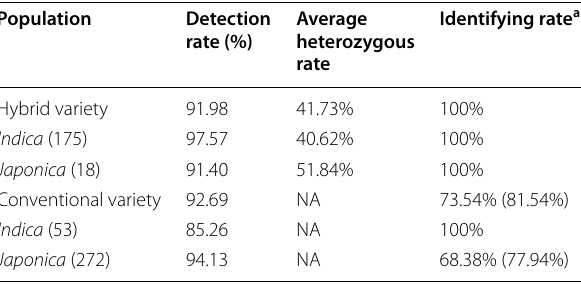
a Identifying rate of 48 markers (identifying rate of 50 markers)